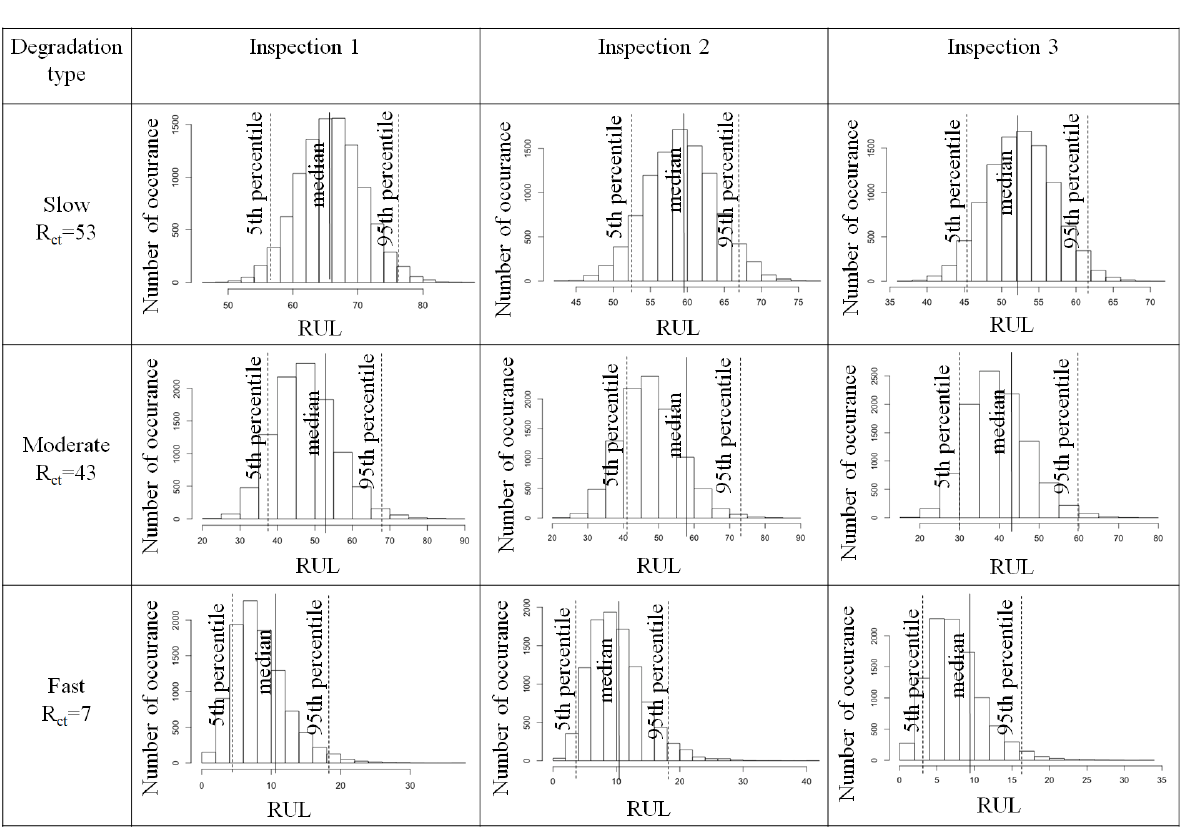
Figure 11. Position of the real crossing time R ct compared to the 5% and 95% percentiles of the RUL histograms for simulated data with NN algorithm at different inspection time: Slow, moderate, and